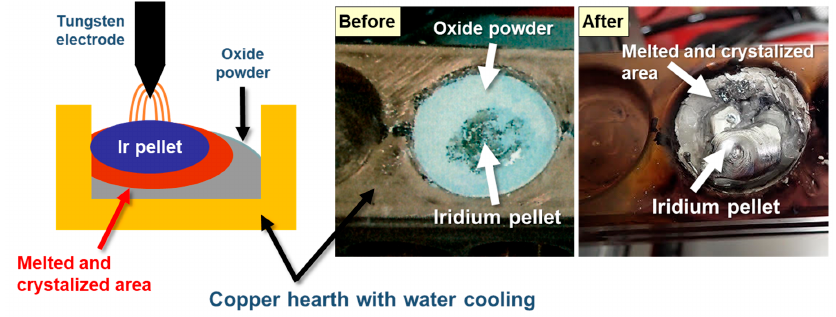
Figure 2. Schematic drawing of the core heating (CH) method at left, and photographs taken before and after crystal growth.